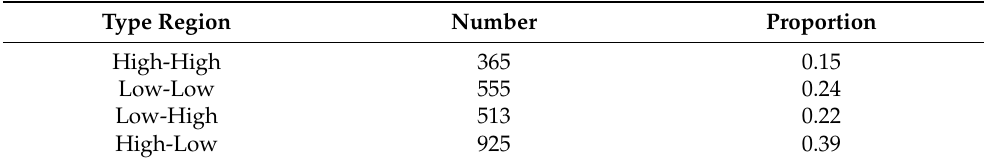
Table 5. The proportion of the four type regions. Type Region